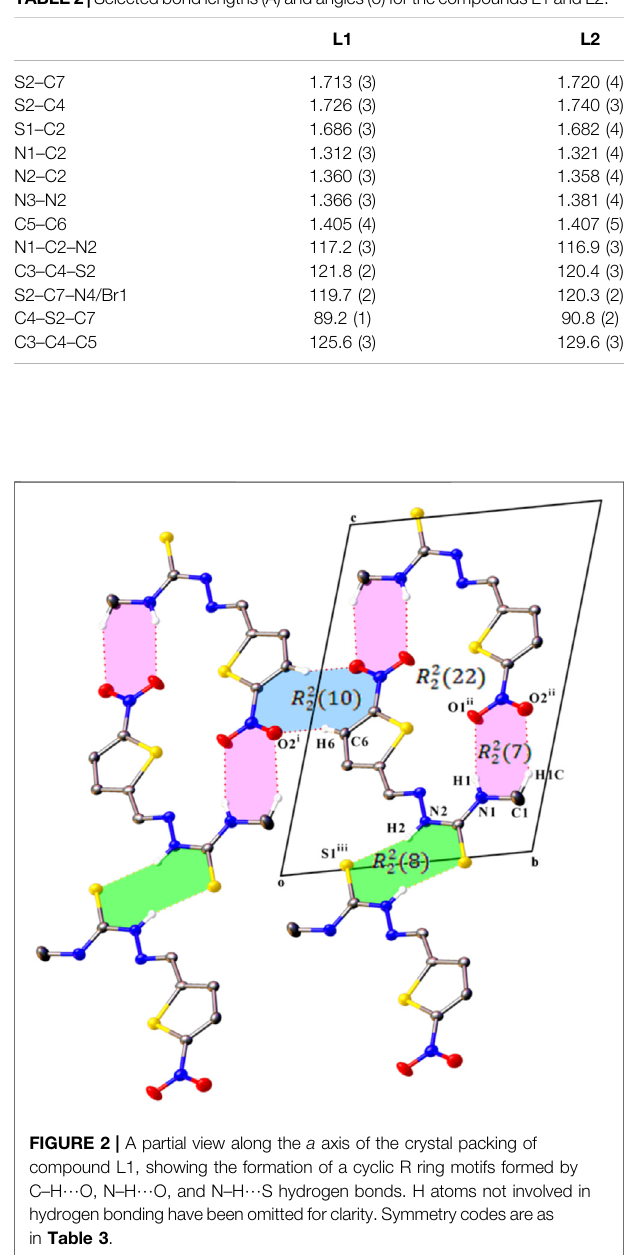
TABLE2| Selectedbondlengths(Å)andangles(o)forthecompoundsL1andL2.